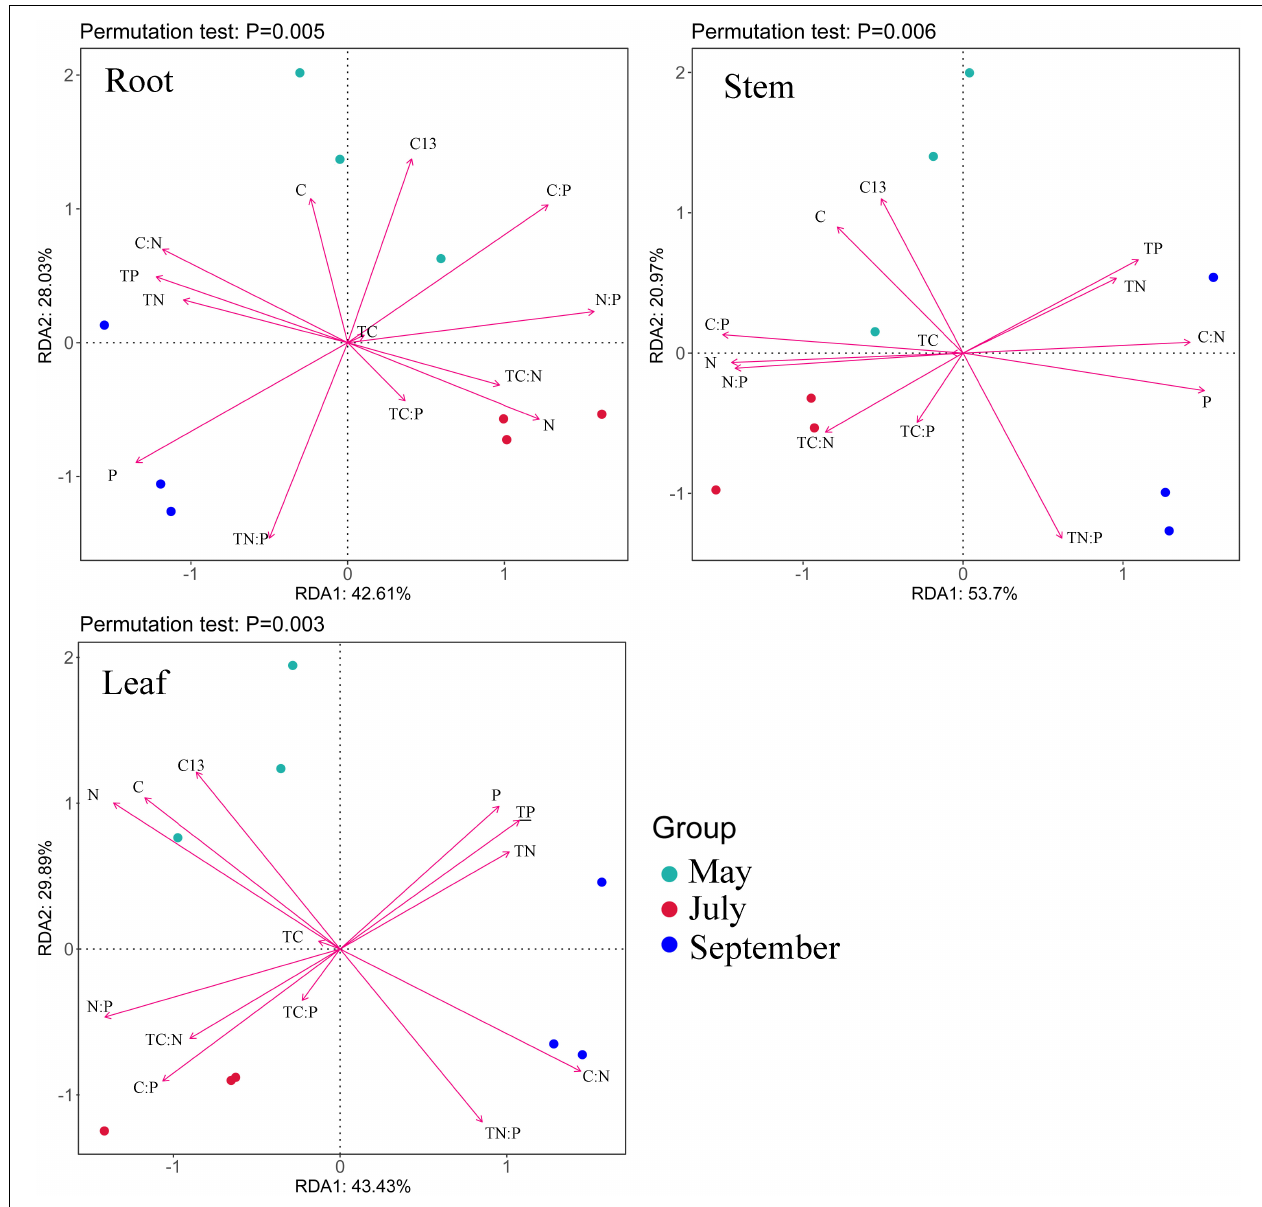
FIGURE 5 | Redundancy analysis of stoichiometry, WUE in M. sibirica and soil nutrients. C, Plant carbon content; N, Plant nitrogen content; P, Plant phosphorus content; C: N, Plant C: N; C:P, Plant C:P; N:P, Plant N:P; C13, Plant WUE; TC, Soil carbon content; TN, Soil nitrogen content; TP, Soil phosphorus content; TC:N, Soil C:N; TC:P, Soil C:P; TN:P, Soil